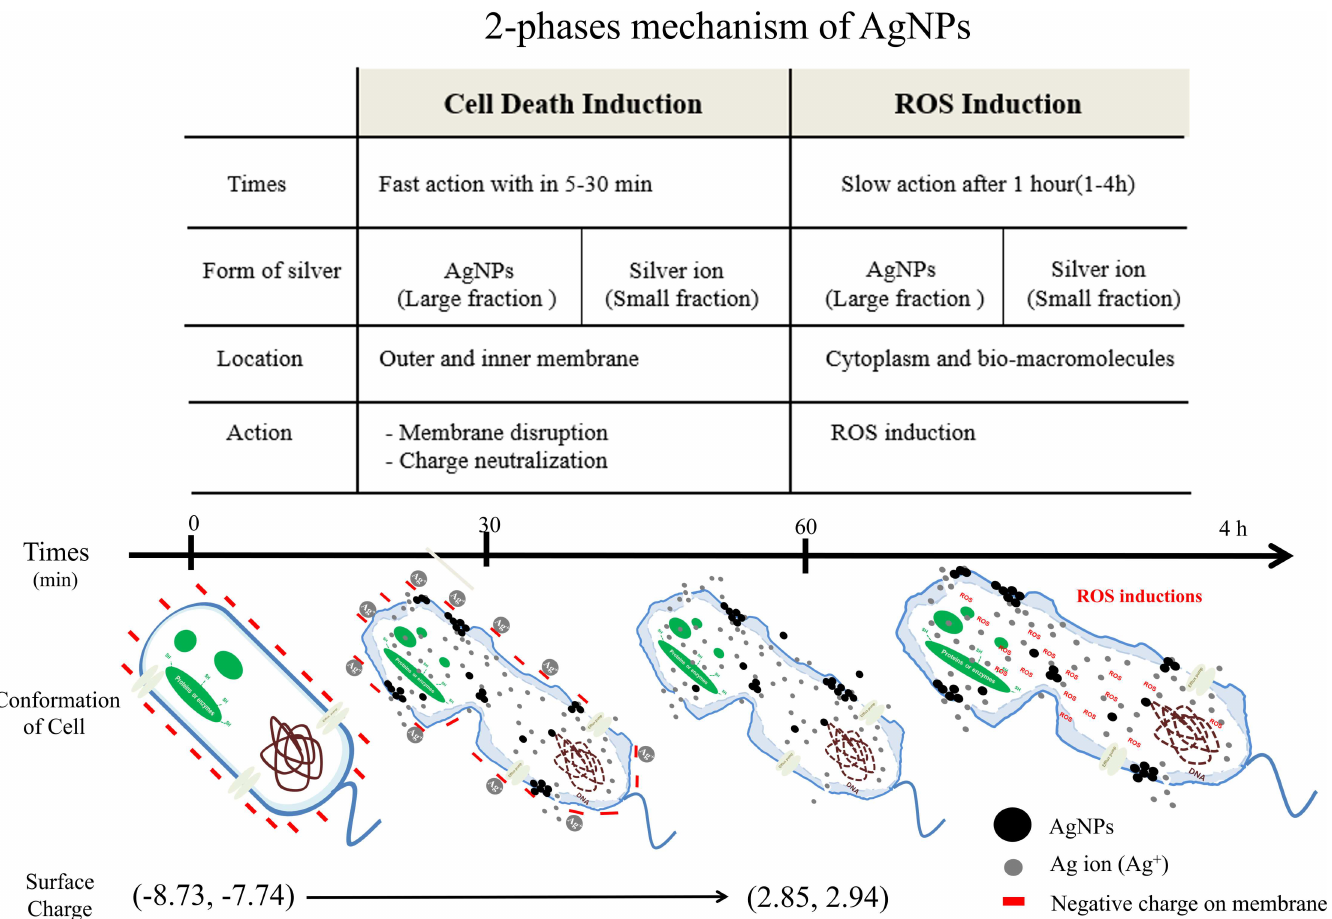
Fig 9. Proposed two-phase mechanism of AgNPs against B . pseudomallei . The two-phasemechanismconsists of a cell death inductionphase and ROS inductionphase. In the cell death inductionphase, AgNPs inducedrapid cell death within 5–30 minutes via the action of large fraction of AgNPs and small fraction of Ag + . The total chargeof the membranewas altered from -8.73 and-7.74 to 2.85 and 2.94 mV due to the neutralization of the positively chargedAg + by negativelychargedmoleculeson the surface of the bacterialcells. Outer and inner membranedisruptionwas evidencedby the fluorescence probe PI. The leakageof cytoplasm and damageof bio-macromolecules was evidencedby a TEM micrographtaken at one hr after AgNP treatment. In the ROS inductionphase, a slow responseof ROS production was found after 1